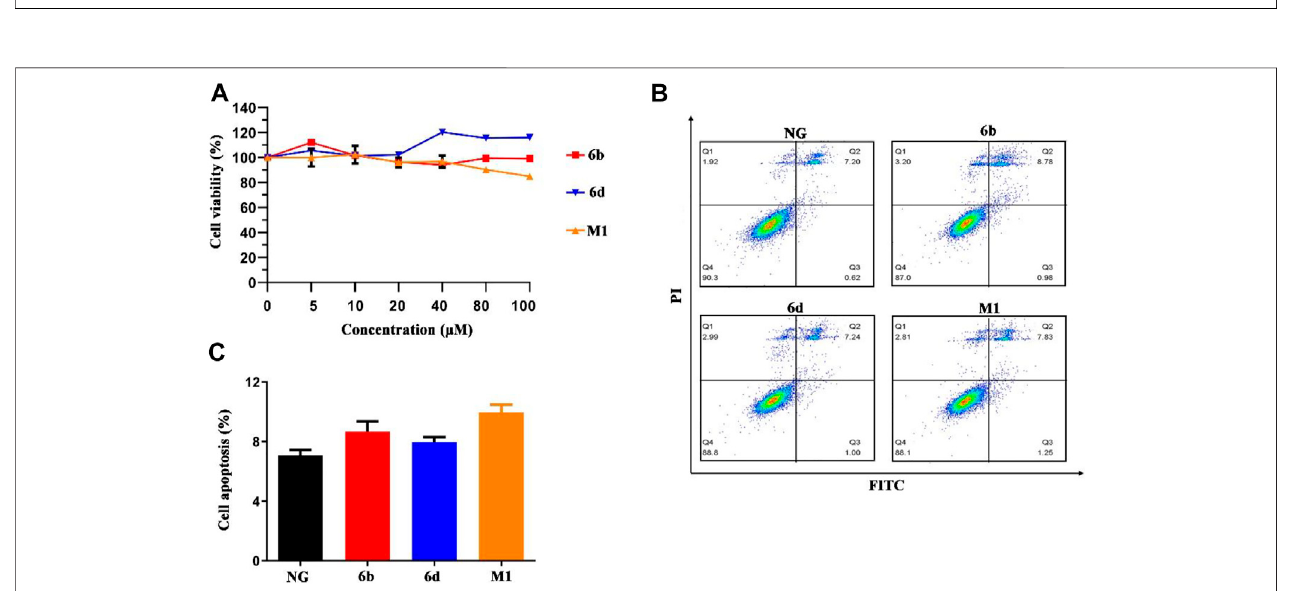
FIGURE 5 | The effect of compounds M1, 6b and 6d on HK-2 cells viability and cell apoptosis. (A) Cell viability analysis of HK-2 cells treated with different concentrationsofthreecompounds. (B,C) HK-2cellstreatedwiththreecompounds(10 μ M)werestainedwithAnnexin V-FITC/PI,and fl owcytometryanalysisshowed the ratio of apoptotic cells. The experiments were conducted at least three times. Error bars: mean ± SD.